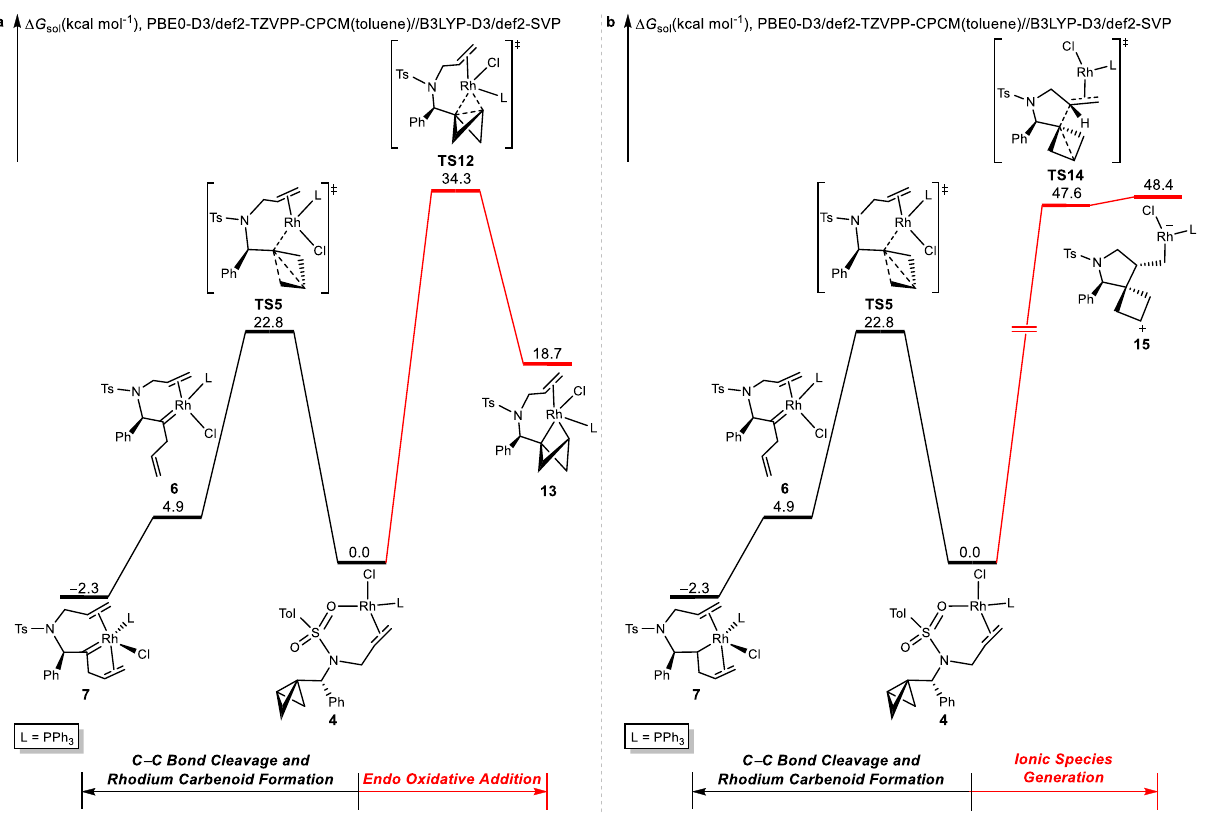
Fig. 5 | DFT analysis of the alternative pathways. a Free-energy changes of the competing rhodium carbenoid fromation (path B in Fig. 2, black line) and endo oxidative addition (transformations from III to IV in Fig. 2, red line) from inter- mediate 4 . b Free-energy changes of the competing rhodium carbenoid fromation